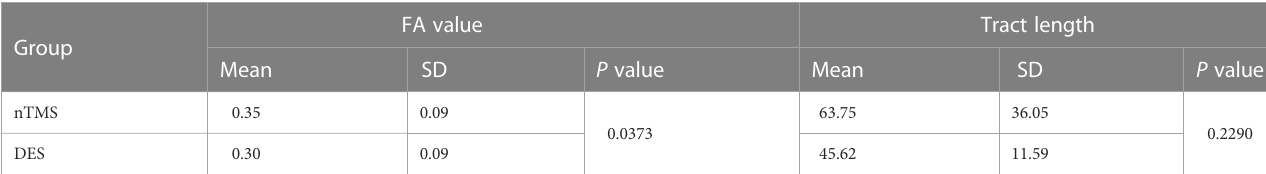
TABLE 1 Analysis of fi ber-tracking results between nTMS and DES.